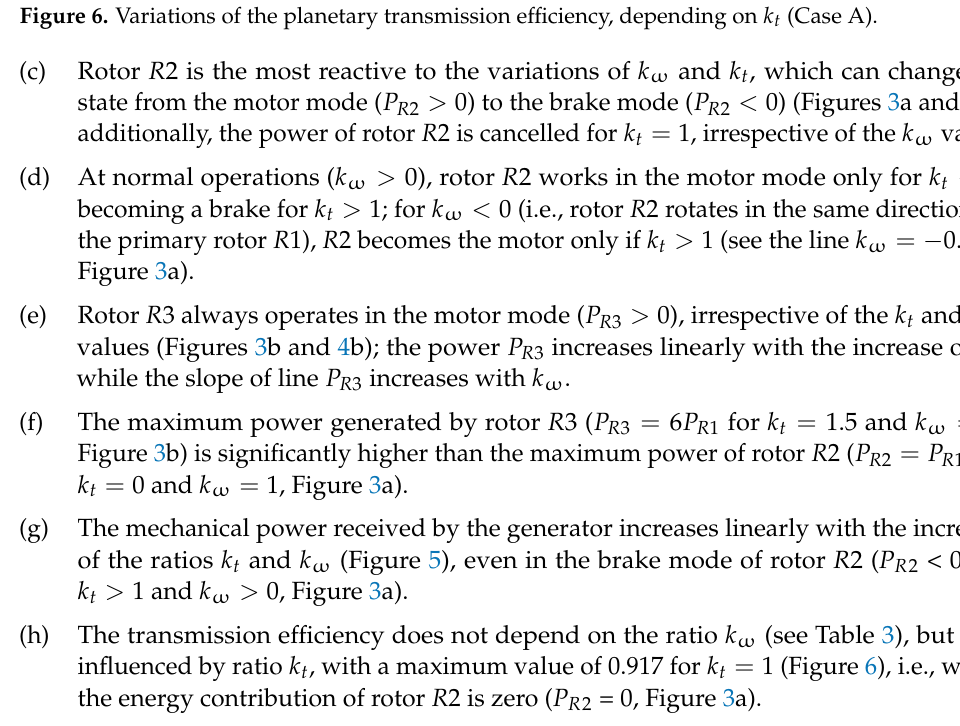
Figure 6. Variations of the planetary transmission efficiency, depending on